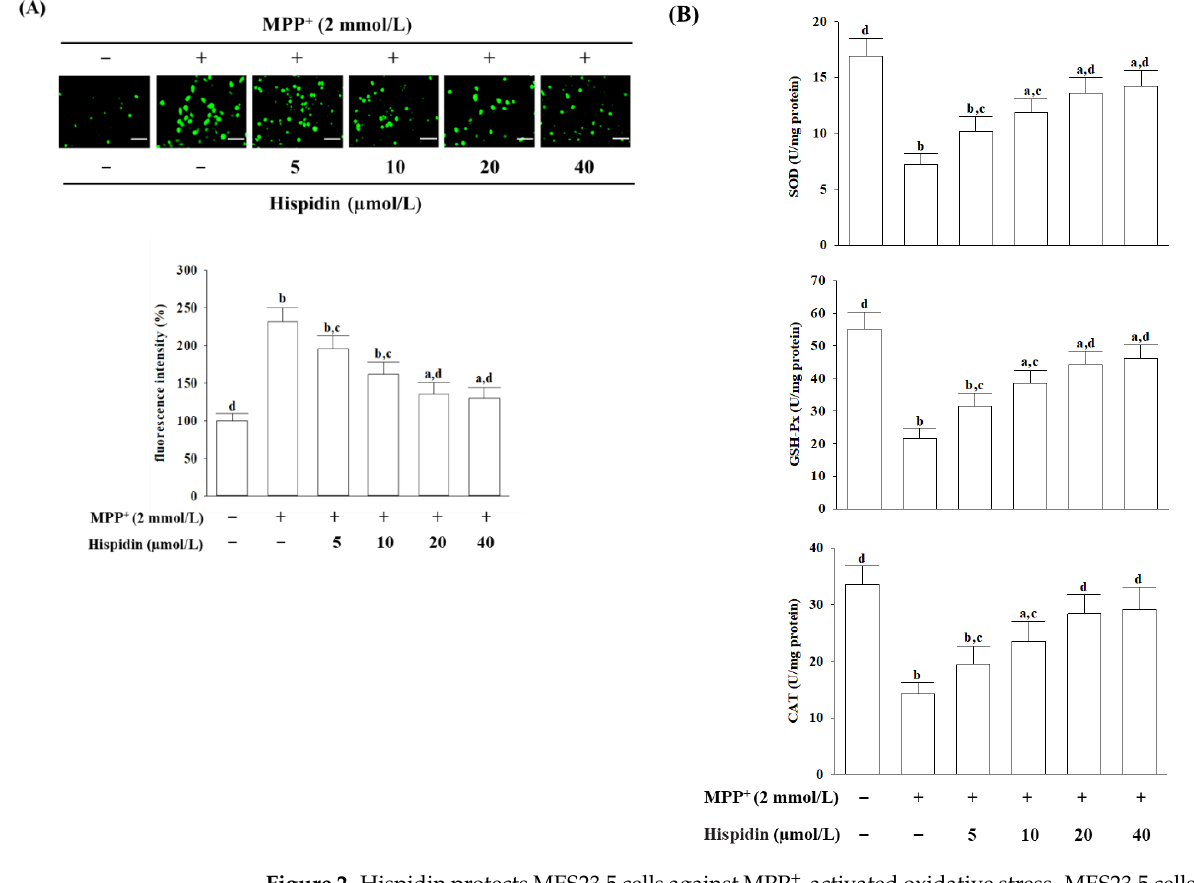
Figure 2. Hispidin protects MES23.5 cells against MPP + -activated oxidative stress. MES23.5 cells were pretreated with hispidin at the indicated concentration for 1 h and then exposed to 2 mmol/L MPP + for another 24 h. ( A ) The image-based measure of ROS in MES23.5 cells was captured by fluorescence microscopy. Scale bar, 50 µ m. The ROS fluorescence intensity is expressed as a percentage of the untreated control cells. ( B ) SOD, GSH-Px, and CAT activities were normalized to the corresponding protein concentration for each group and expressed in units per milligram of protein. The results are shown as the mean ± SD of five independent experiments ( n = 5) performed in triplicate. a p < 0.05 and b p < 0.01 compared to the untreated control group. c p < 0.05 and d p < 0.01 compared to the untreated MPP +